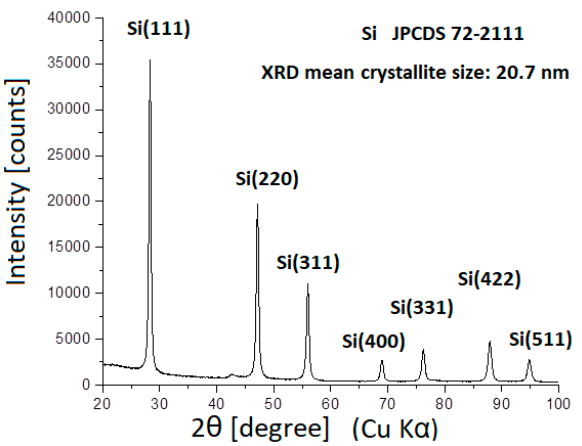
Figure 2. X-ray diffractogram of raw Si nanoparticle nanopowder.